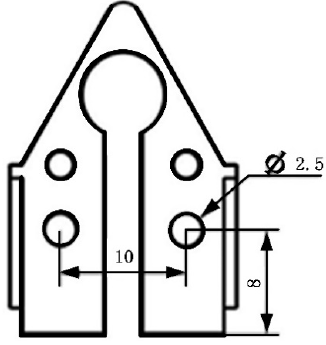
Figure 8. Open hole to optimize stator dynamic characteristics.